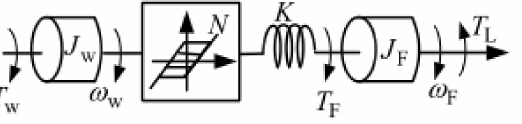
Figure 3. The mechanical structure schematic diagram of the two-mass wind turbine